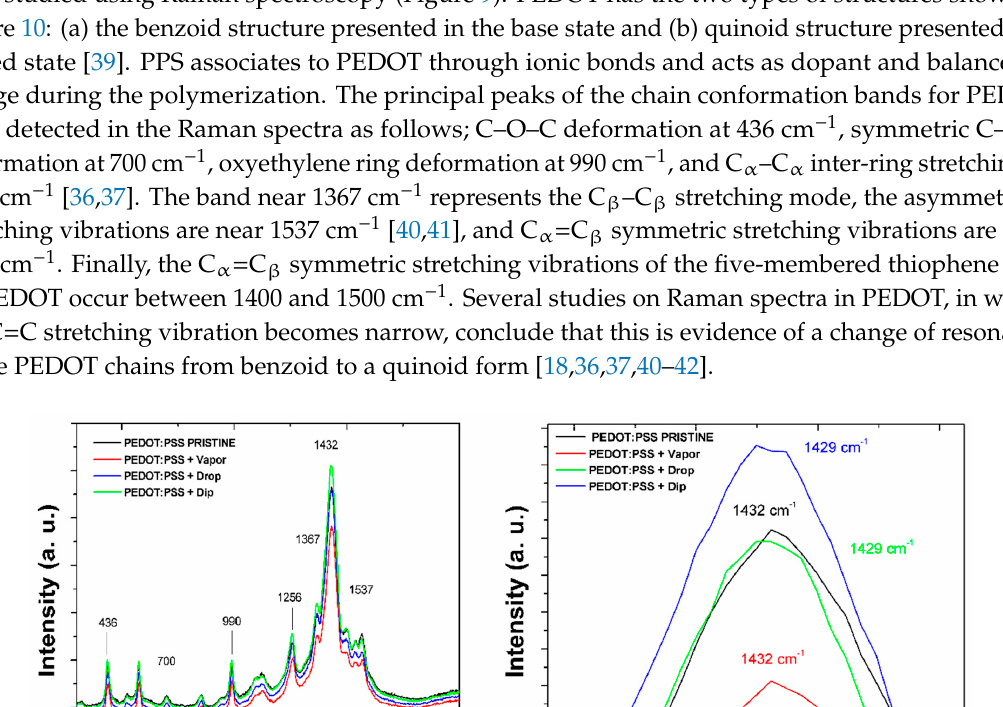
Figure 10. Chemical structures of the ( a ) benzoid and ( b ) quinoid forms of PEDOT. Hybrid pin structures with pristine and post-treated PEDOT:PSS films were fabricated. Figure 11 and Table 3 show the J (U) characteristics of the h-pin structures labeled as H3-PRISTINE, H4- VAPOR, H5-DROP, and H6-DIP structures. The H3-PRISTINE reference structure exhibits J (U) characteristics as V oc = 780 mV, J sc = 16 mA/cm 2 , FF = 0.36, and a PCE = 4.6%. The lowest open-circuit voltage of V oc = 695 mV was obtained in the H4-VAPOR structure; characterization of post-treated PEDOT:PSS films demonstrated that the effect of post-treatment using the vapor technique on electronic and morphological characteristics is weak and limited to the surface. Moreover, the nature of the vapor treatment may produce nonuniform changes in the surface. This can be confirmed by the variability in work function values obtained for the vapor post-treated film characterization (Table 2) and can explain the low V oc in the H4-VAPOR structure. In contrast, the H5-DROP and H6- DIP structures present higher open-circuit voltages than that in H3-PRISTINE structure. In the previous section, it was demonstrated that drop and dip post-treated PEDOT:PSS films were modified by IPA forming an enriched-PEDOT bulk with preferential quinoid conformation and an